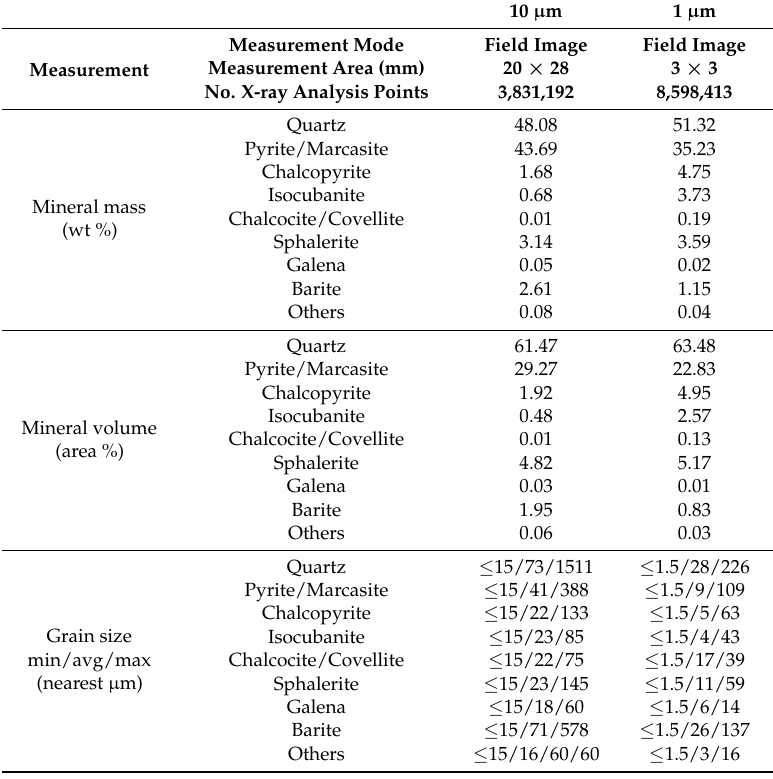
Table 2. Mineralogy of mineralised material after QEMSCAN analysis, performed at 10 and 1 µ m pixel resolution, i.e., beam step size. Mineralogical data is normalised and is reported to the nearest 100 ppm. A minimum grain size of ≤ 15 or ≤ 1.5 µ m is a product of scan resolution (fields are overlapped for